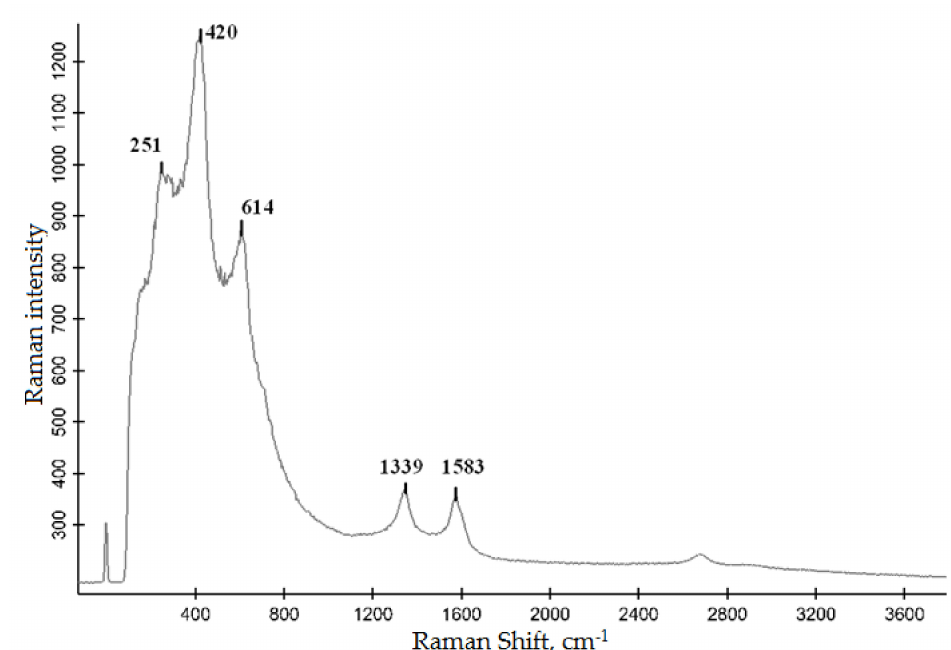
Figure 6. Raman spectra of the surface in local areas of treated